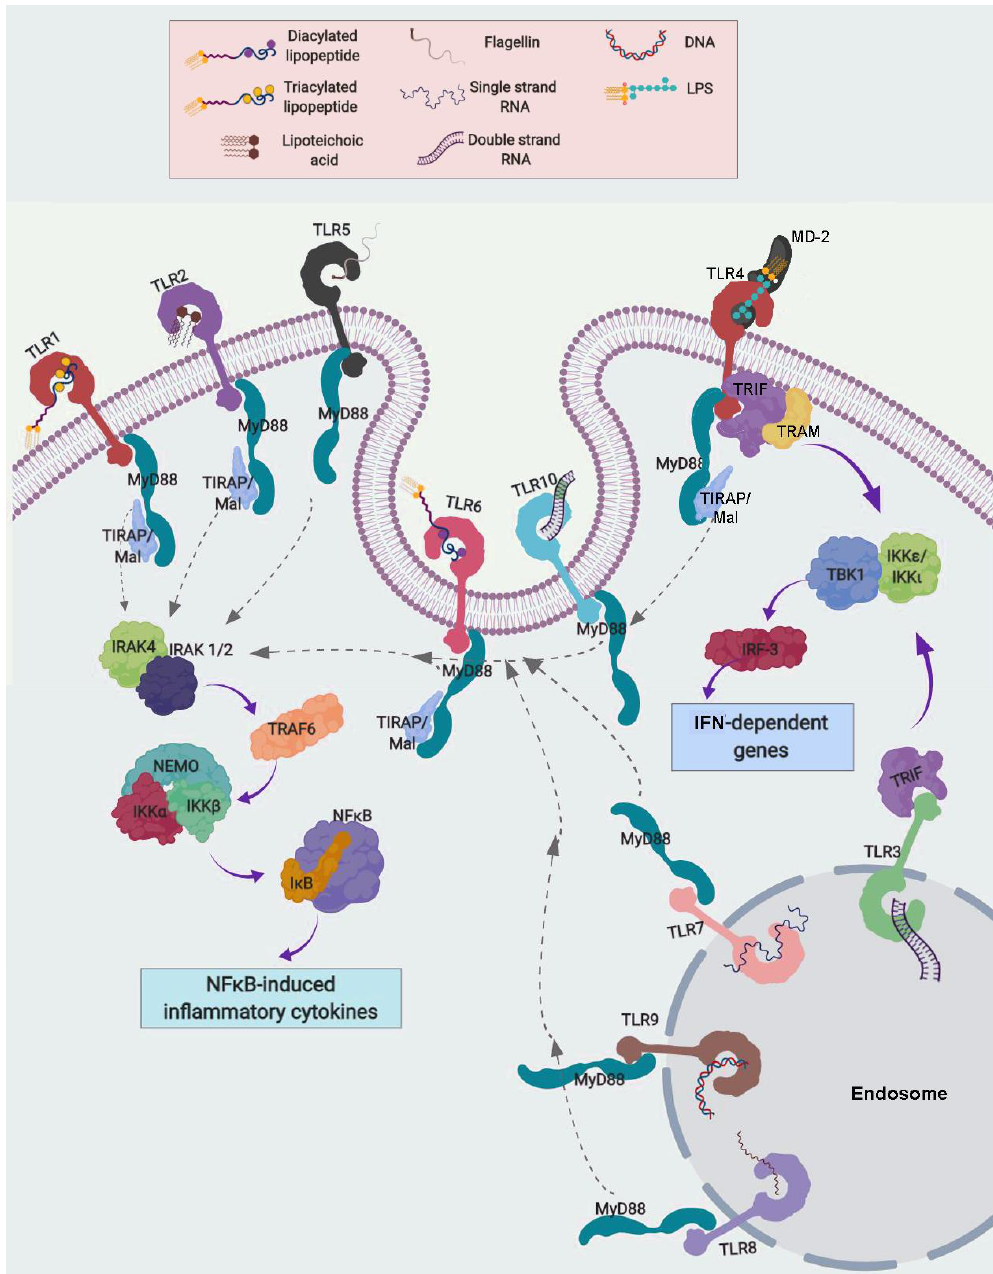
Figure 2. Toll-like receptor (TLR) signaling. Myeloid differentiation factor 88 (MyD88)-dependent and -independent pathways. The main ligands associated to TLRs are indicated, and required their TLR homo- or hetero-dimerization for its activation. All TLRs, except TLR3, can activate the MyD88-dependent pathway. TIR domain containing Adaptor Protein (TIRAP) is associated to TLR1, TLR2, TLR4 and TLR6 and can activate the MyD88-dependent pathway, which involves the activation in cascade of IL-1 receptor-associated kinase (IRAK)-4, IRAK-1/2, TNF receptor-associated factor (TRAF)-6, the IκB Kinase (IKK) complex and IκB proteins, which results in IκB ubiquitination and degradation. Then, NF-κB can freely translocate to the nucleus and modulate the expression of genes containing NF-κB binding sites. The MyD88-independent pathway is activated only by TLR3 and TLR4 through their association with the TIR Domain-Containing Adapter Protein Inducing IFN-β (TRIF) and the Translocation Associated Membrane Protein (TRAM), which phosphorylates the IKK ε -IKK ι -TBK1 complex. This finally activates interferon regulatory factor 3 (IRF3), which activates IFN- α and - β transcription, as well as other interferon-induced